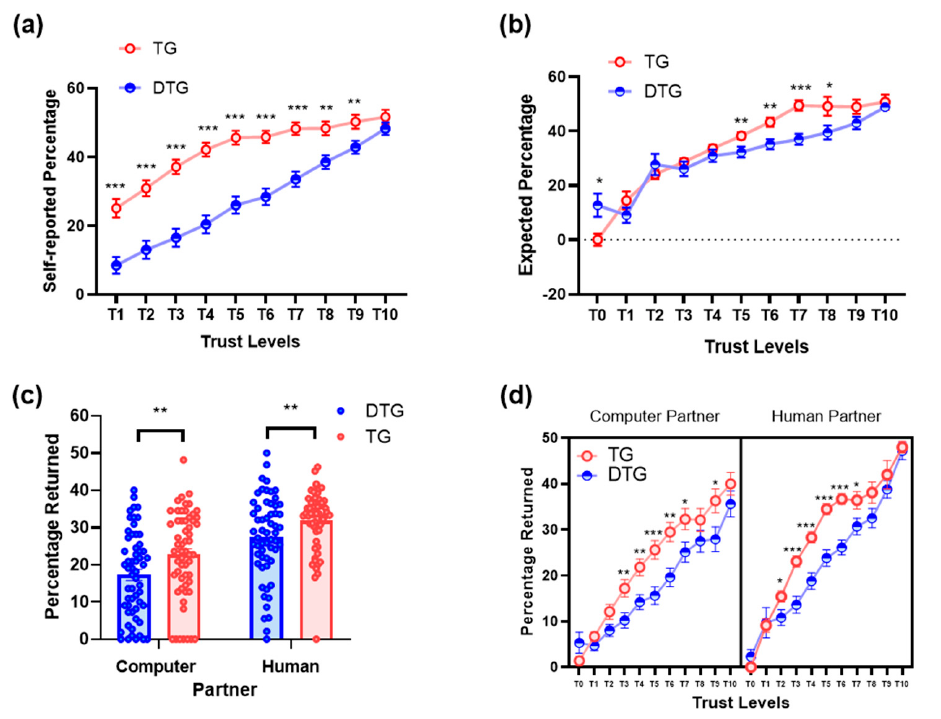
Figure 1. The percentage of return in the trust game (TG) and distrust game (DTG). ( a ) Self-reported reciprocity. The self-reported percentage of return as a function of trust levels for human partners measured by the scenario version in Session 1. Self-reported percentages of return were significantly higher in the TG than the DTG group at the levels of trust 1 to trust 9. ( b ) Expected reciprocity. The expected percentage of return as a function of trust levels for human partners measured in Session 2. Expected percentages of return were significantly higher in the TG than the DTG group at the levels of trust 5 to trust 8. Expected percentage of return was significantly higher in the DTG than the TG group at the levels of trust 0. ( c ) Average reciprocity. The actual percentage of return as a function of partners and game measured in Session 3. Actual percentages of return were significantly higher in the TG than the DTG group. ( d ) Actual reciprocity. The actual percentages of return as a function of partners, game, and trust levels measured in Session 3. For computer-mediated partners, actual percentages of return were significantly higher in the TG than the DTG group at the levels of trust 3 to trust 7, and trust 9. For human partners, actual percentages of return were signif- icantly higher in the TG than the DTG group at the levels of trust 2 to trust 7. Bars and error lines indicate the mean value and the standard errors of means. * p < 0.05, ** p < 0.01, *** p < 0.001. Table 1. Descriptive ( M [ SD ]) and t -test results on demographic and self-reported measures in the trust game (TG) and distrust (DTG) groups.